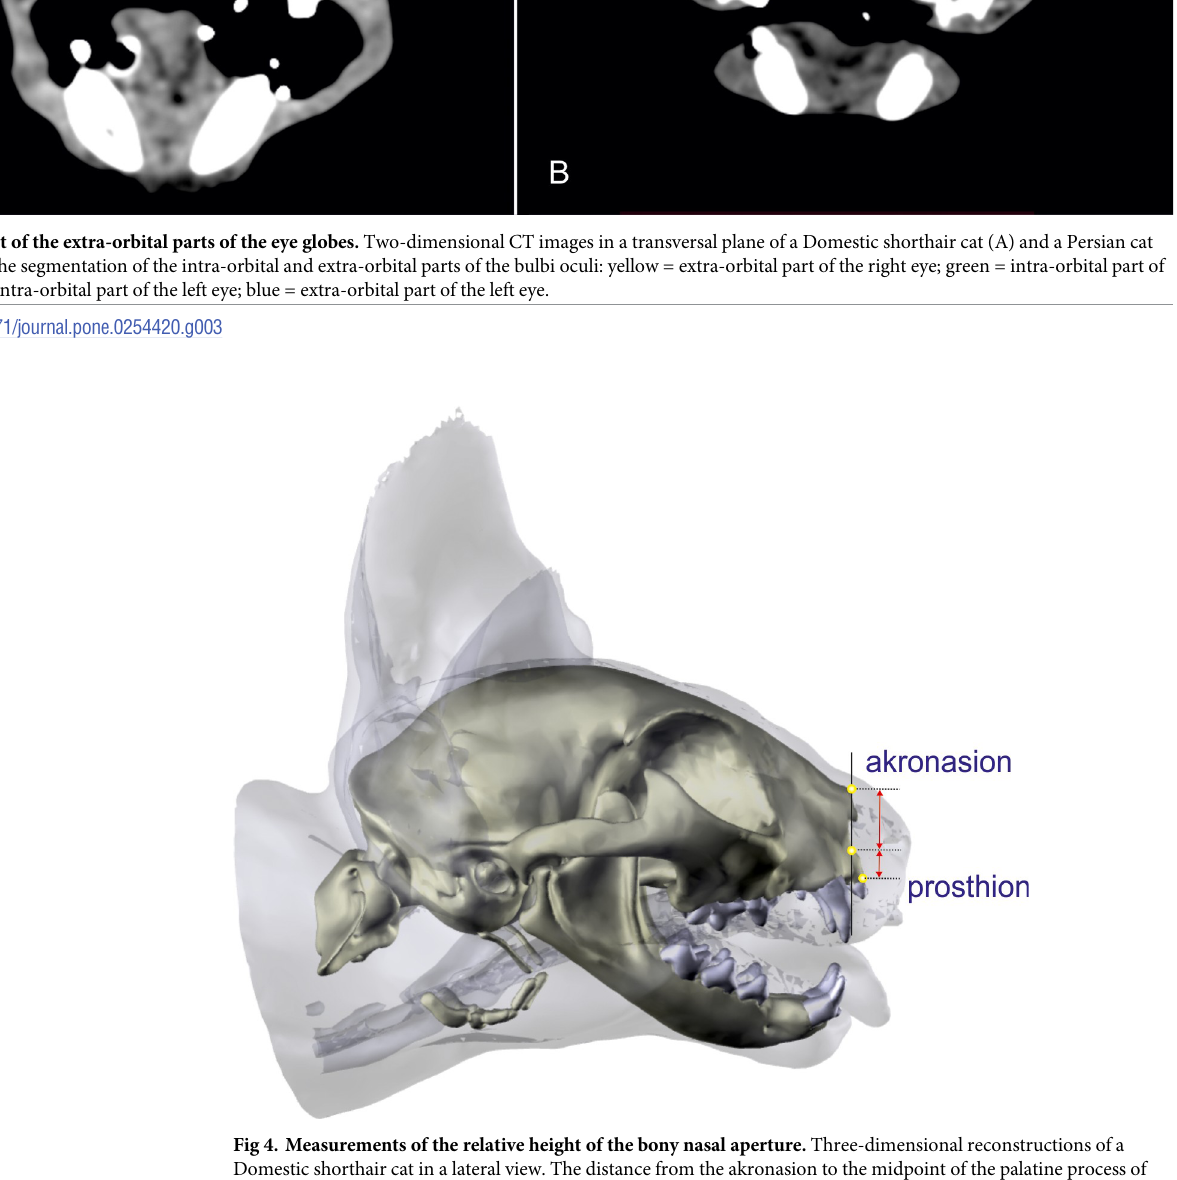
PLOS ONE | https://doi.org/10.1371/journal.pone.0254420 July 21,